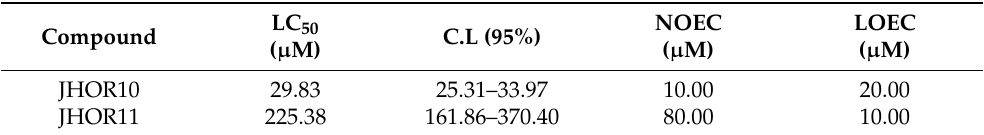
Table 2. LC 50 (with 95% confidence limit), NOEC and LOEC for ruthenium compounds JHOR10 and